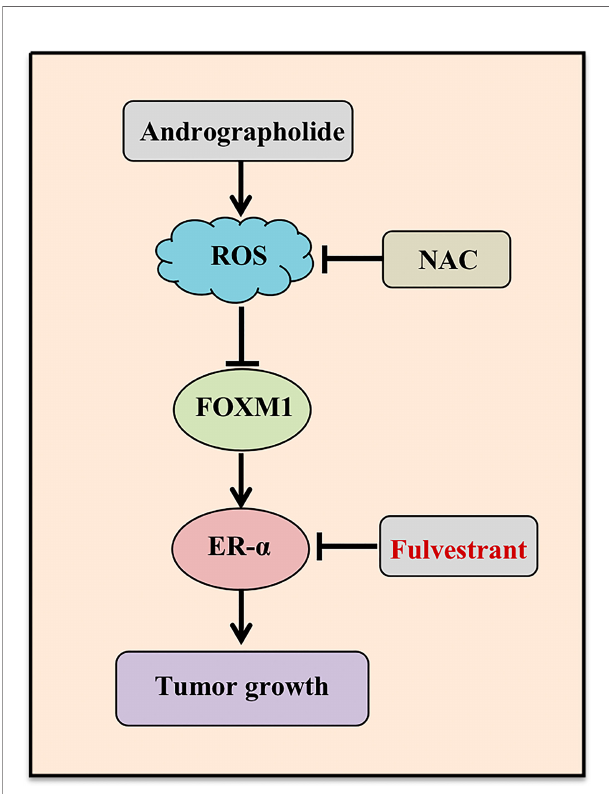
FIGURE 6 | Working model. AD suppressed ESR1 transcription through ROS-FOXM1 axis and synergized with fulvestrant to inhibit ER- a expression and breast cancer